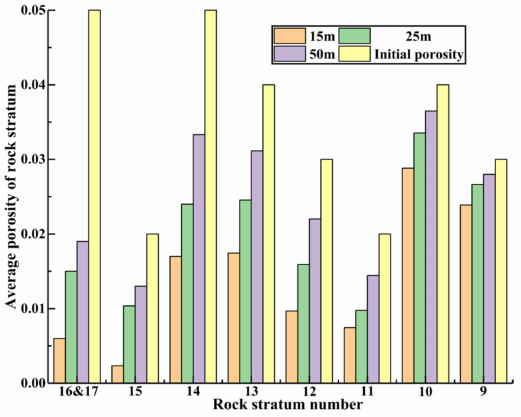
Figure 17. Average porosity value of overlying strata in the